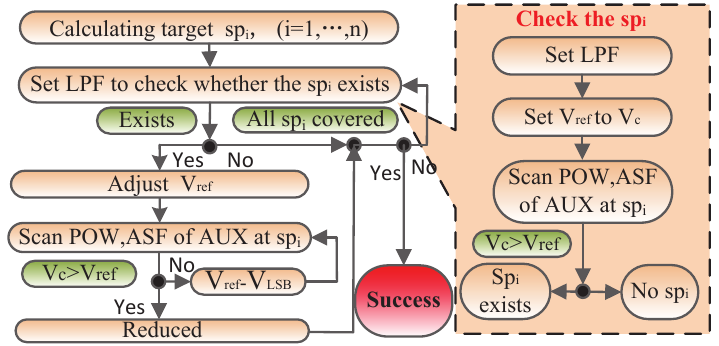
Figure 5. Algorithm flow of the proposed spur detection